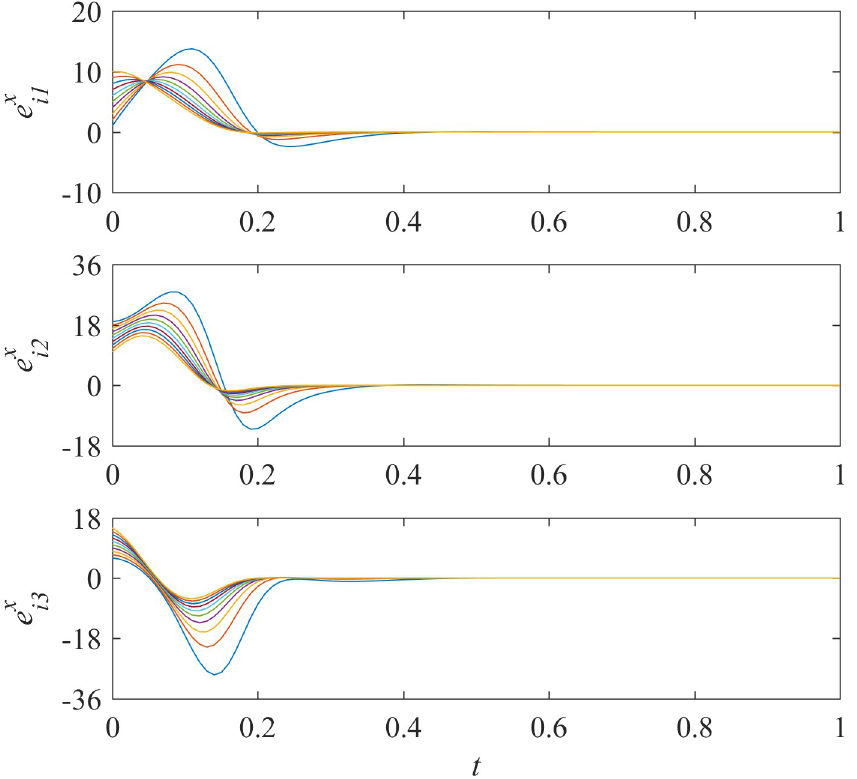
Fig 5. States of error system between the nodes and the isolate node in sub-network X (Eq (3)).